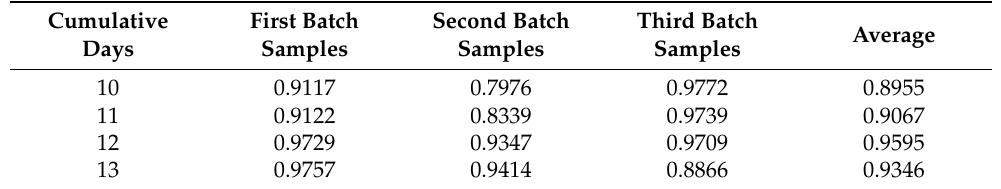
Table 1. Numerical distribution table of adjacent regions with maximum values of the coefficient of determination in different batches.